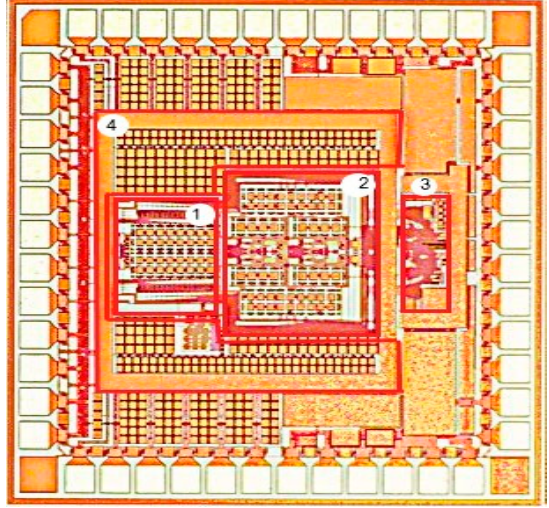
Figure 13. Modulator chip layout, where (1) is the multiplexed sampled capacitor array, (2) is the 2 nd -order integrator, (3) is the comparator and (4) is the power supply.